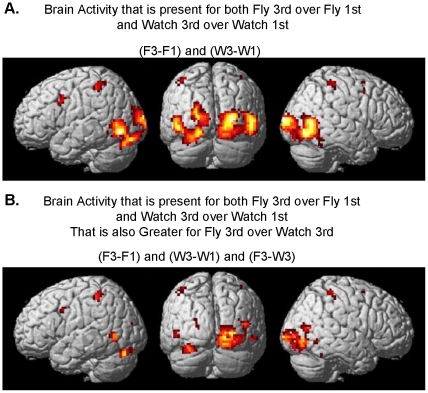
Differential 3rd person brain activity present during both execution and observation of action.Random-effects results rendered on the normalized brain denoting ‘Mirror Neuron’ system characteristics in that the differential activity is present both for flying (execution) and watching (observation) conditions A. (F3-F1) and (W3-W1) with the additional constraint that the activity be greater for the flying (execution) condition B. (F3-F1) and (W3-W1) and (F3-W3) (pFDR <0.05 corrected for multiple comparisons).